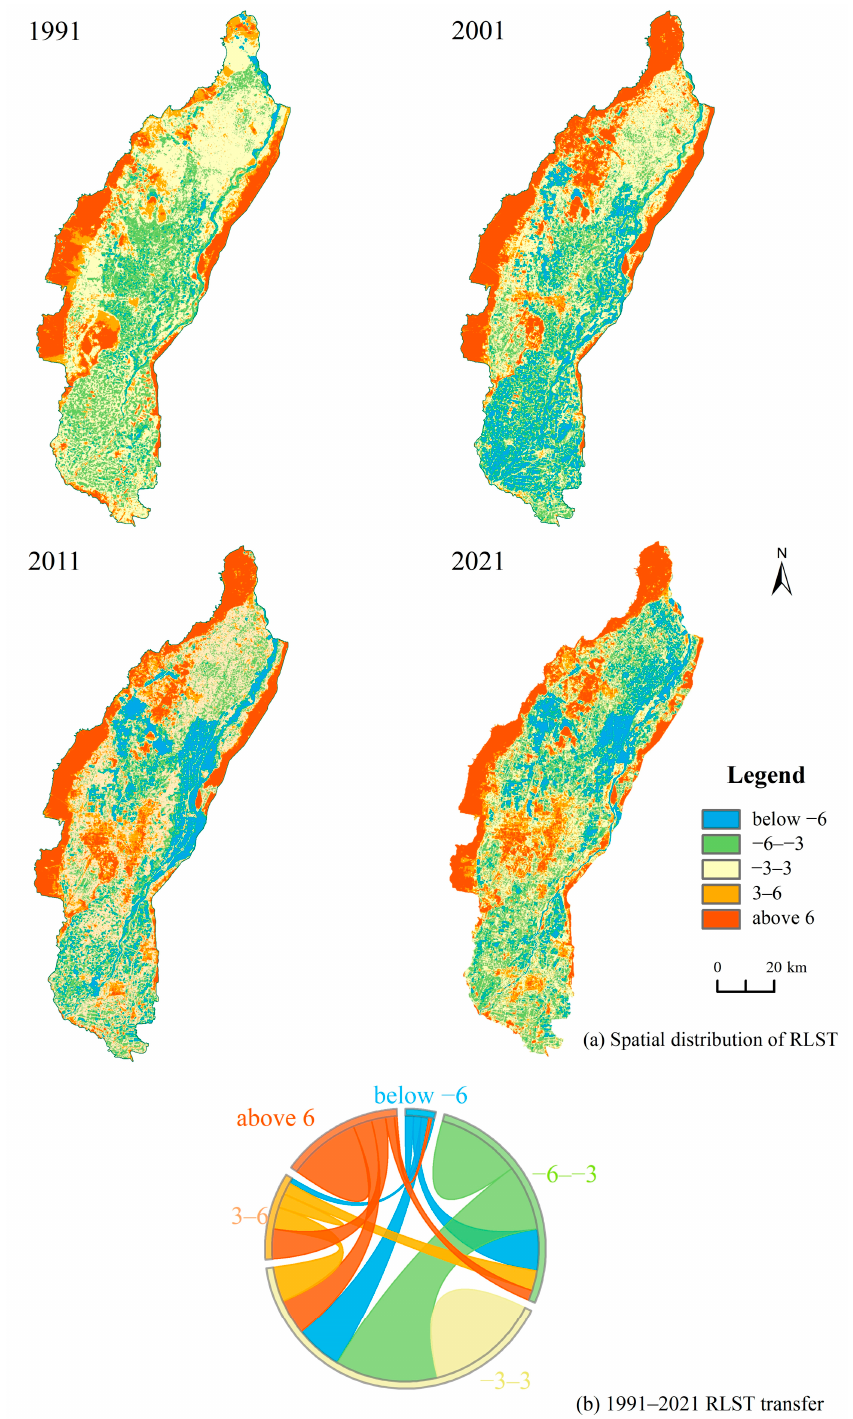
Figure 2. Spatiotemporal pattern of and variation in RLST: ( a ) spatial distribution of RLST from 1991 to 2021; ( b ) transformation of RLST from 1991 to 2021. According to RLST, the heat island intensity is classified into 5 classes: − 6 ≥ low, − 6 < sub-low ≤ − 3, − 3 < medium ≤ 3, 3 < sub-high ≤ 6, and 6 < high.